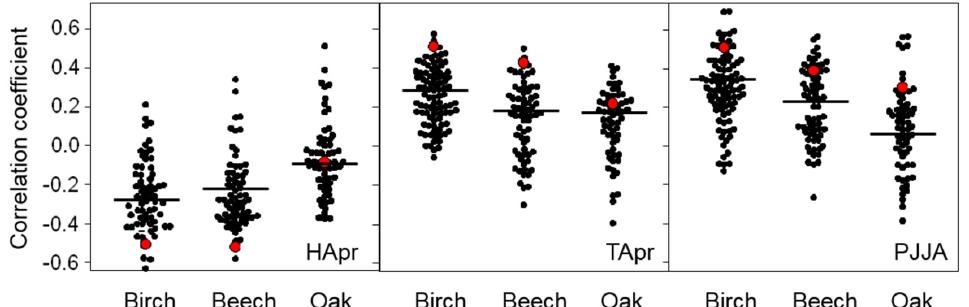
Figure 4. Individual tree climate–growth correlation coefficients calculated for the three tree species mean temperature (TApr), and summer precipitation (PJJA, June-July-August precipitation). The red dots represent the species climate–growth correlations, the black dots show individual climate–growth correlations, and the horizontal lines indicate the medians of individual